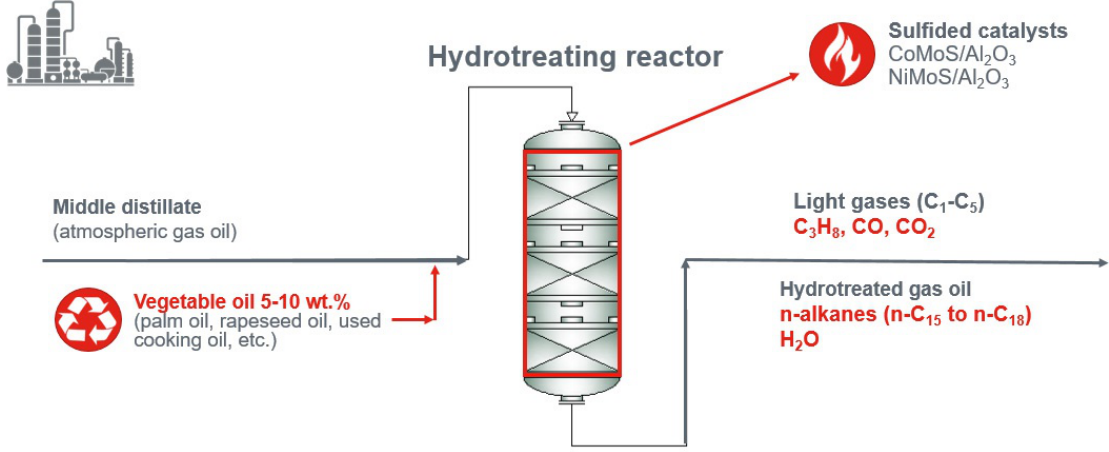
14 of 30 Figure 2. NExBTL catalytic hydrotreating of oils/fats technology for biodiesel production (Neste ® 2021) [132] . The co-processing of middle distillates (e.g., straight-run gas oil) with vegetable oils (rapeseed oil, sunflower oil or even waste cooking oils) seems to be the most promising way to produce HVO on an industrial scale. In this way, the co-processing approach al- lows using the infrastructure already available in the existing refineries [133], that is, hy- drotreating units, commonly used for sulphur compound elimination (among others) from diesel fractions. Moreover, using waste oils (using cooking oils or animal fats) also offers an efficient way of managing residues [134], obtaining a valuable biofuel integrated with the petroleum fraction [135]. Several studies have already been published relating to the co-processing of different crude oil feedstocks (heavy gas oil, vacuum gas oil, and atmospheric gas oil) with vegeta-